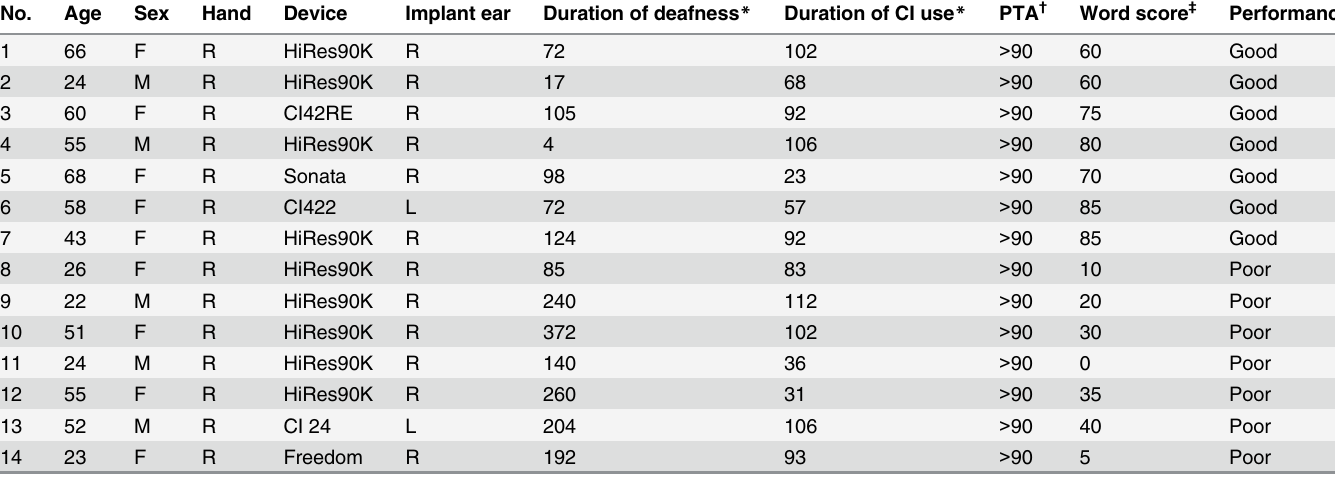
Table 1. Demographics of cochlear implant